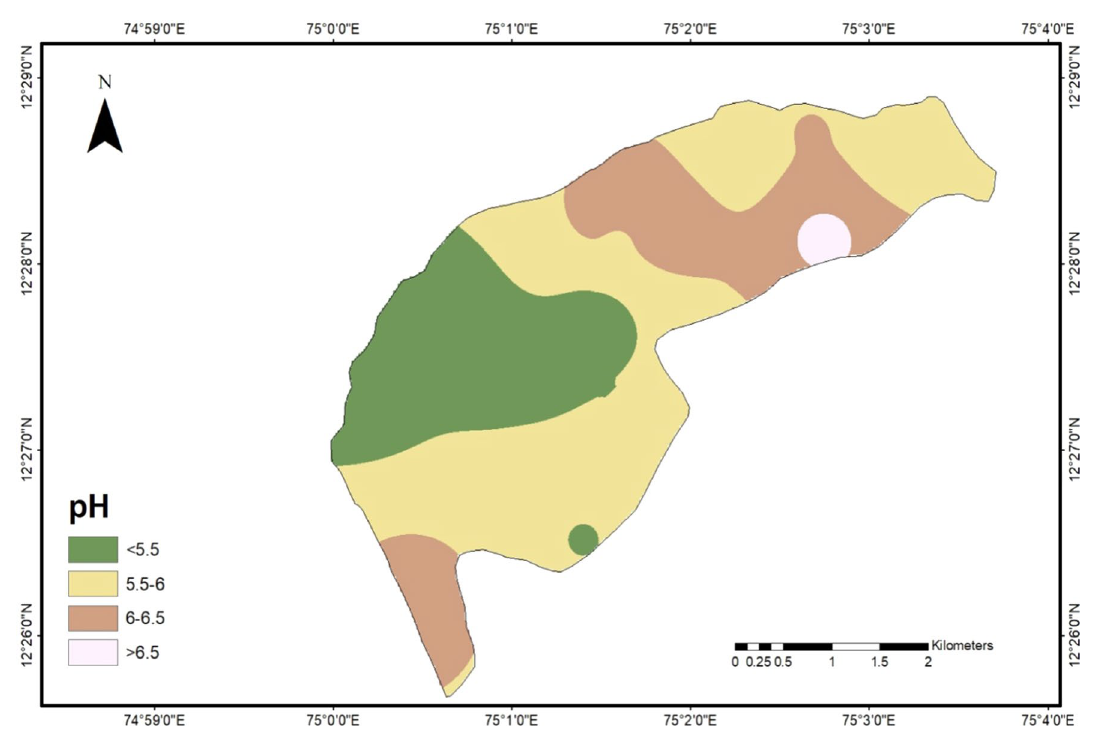
Fig. 2 Spatial variation of pH in the Kalanad basin